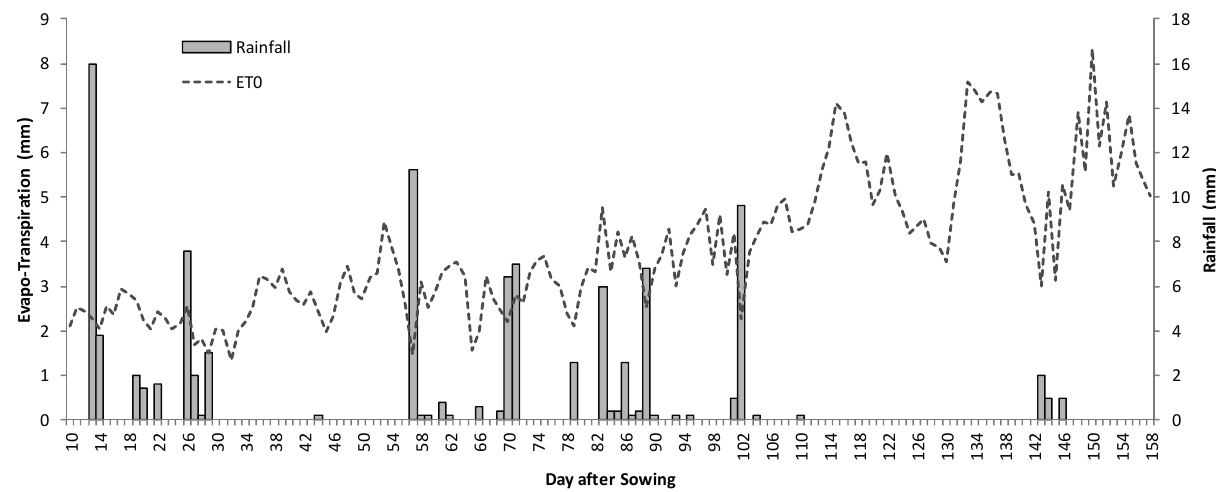
Figure 4. Time evolution of Rainfall and Reference Evapotranspiration (ET 0 ) during the experimental